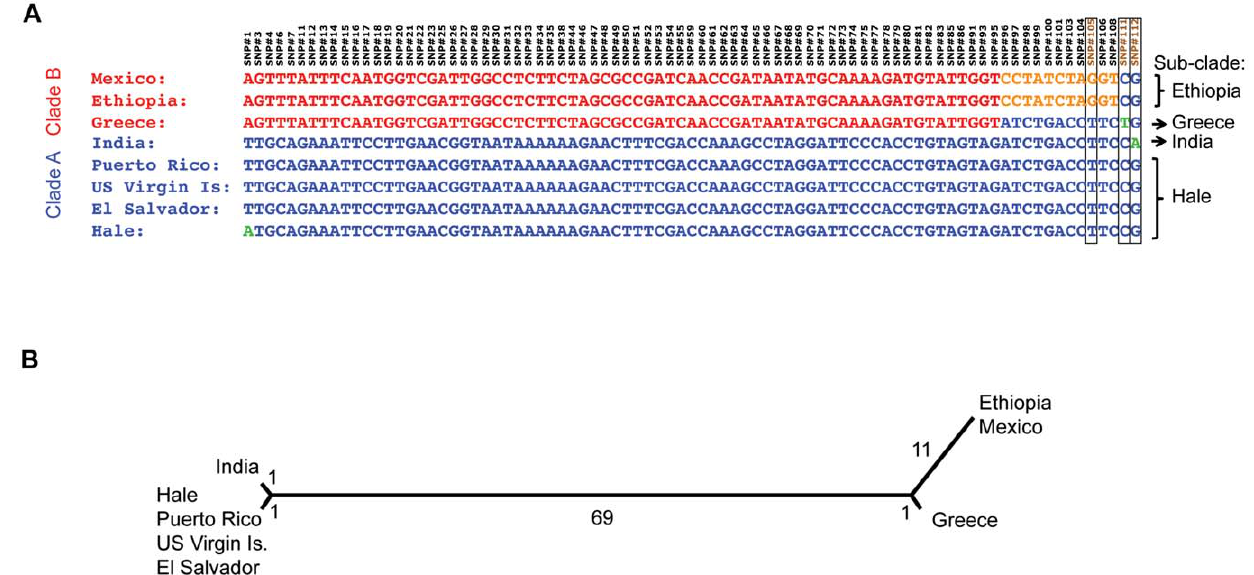
Figure 4. SNP identification and phylogeny obtained from genomic sequencing of 8 castor bean accessions. A) 83 high quality SNPs identified in the chloroplast genomes of the 8 sequenced chloroplast accessions. The two major clades are shown in red and blue and SNPs that differentiate different sub-clades are shown in orange or green. B) Phylogeny of the 8 castor bean accessions based on the identified SNPs. Two major clades, ‘‘A’’ and ‘‘B’’, are shown separated by 69 SNPs. Members of each sub-clade are indicated in each branch of the phylogeny.